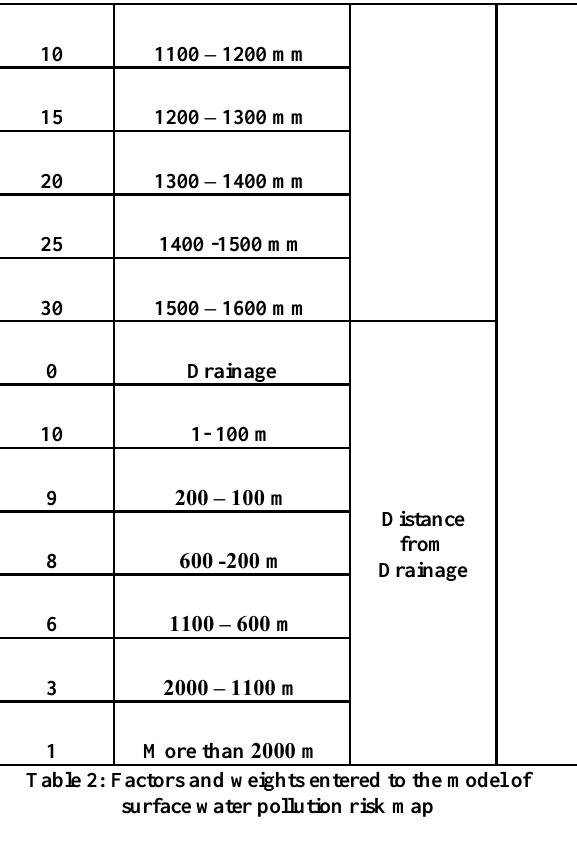
Table 2: Factors and weights entered to the model of surface water pollution risk map 4.